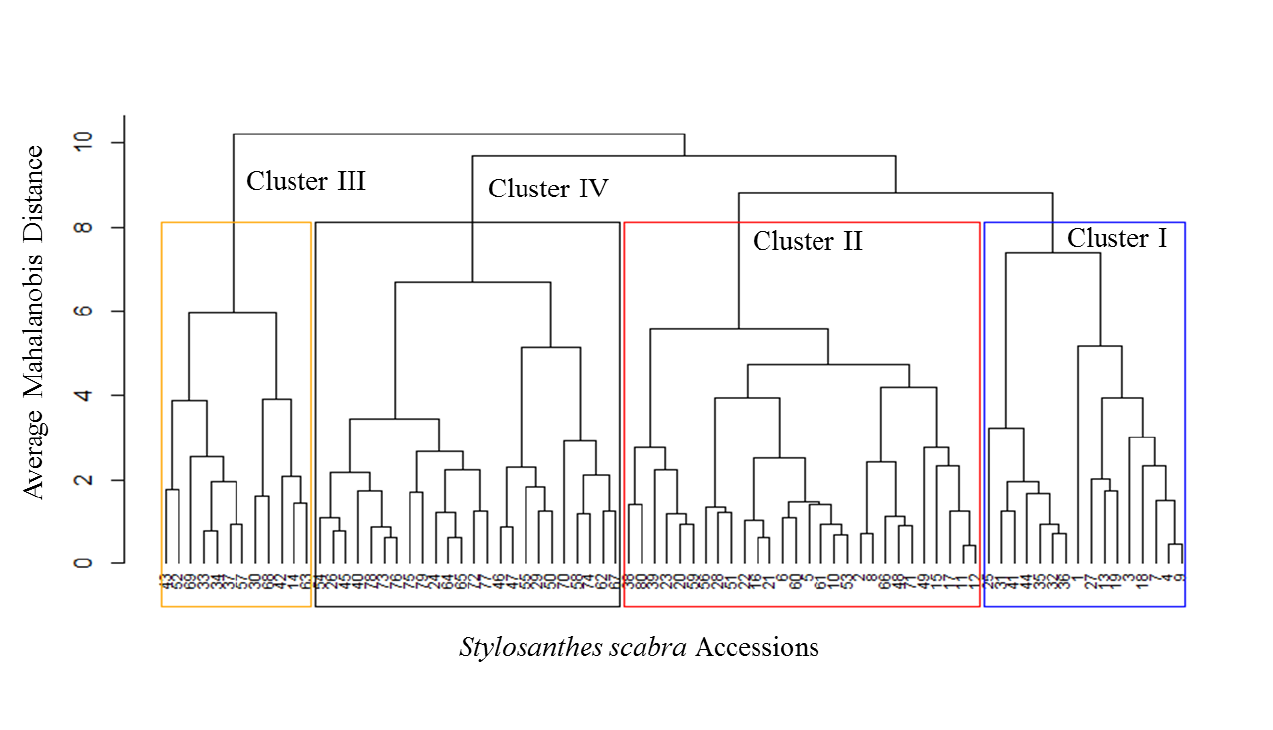
Figure 2. Dendrogram illustrating the distribution of 80 accessions of Stylosanthes scabra Vogel in four clusters based on Mahalanobis distance. The accessions are numbered as in Table